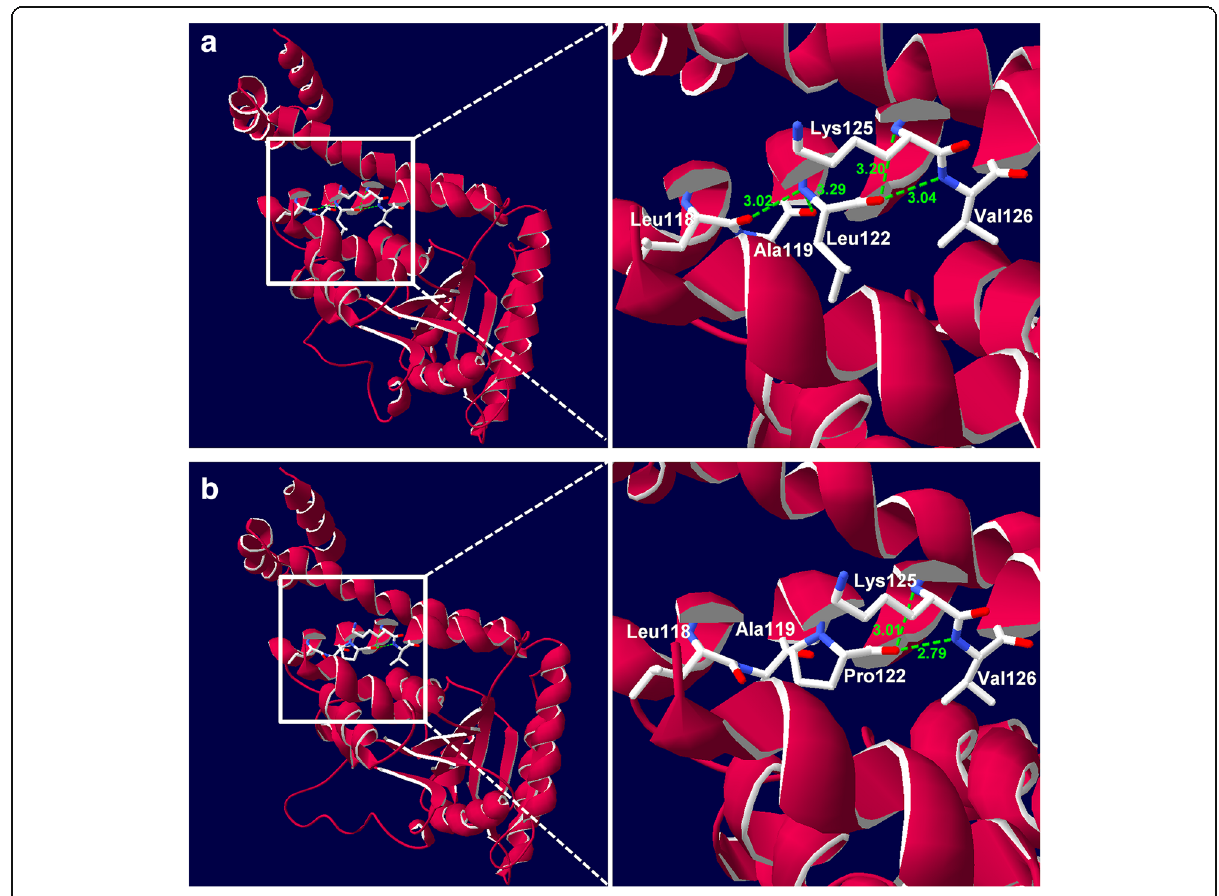
Fig. 2 Structural analysis of the wild-type and MMAA mutant products using three-dimensional modelling. Green dashed lines represent hydrogen bonds, and the green Arabic numbers show the hydrogen bond distances. a A segment of the MMAA structure showing Leu122 hydrogen bonding with Leu188, Ala119, Lys125, and Val126. b A segment showing that Pro122 lost two intramolecular hydrogen bonds, one with Leu188 and one with Ala119, leading to instability of the protein